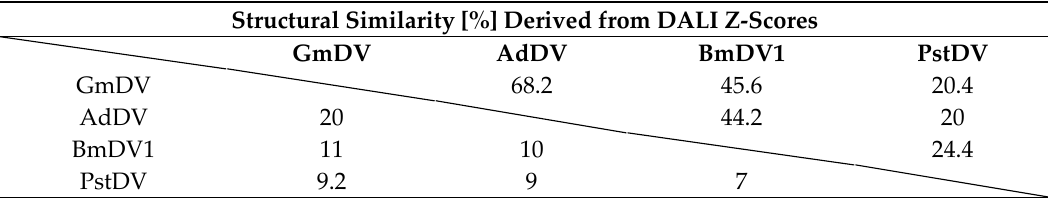
Table 6. Sequence identity and structural similarity for densoviruses. T able 6 Sequence identity and structural similarity for densoviruses.